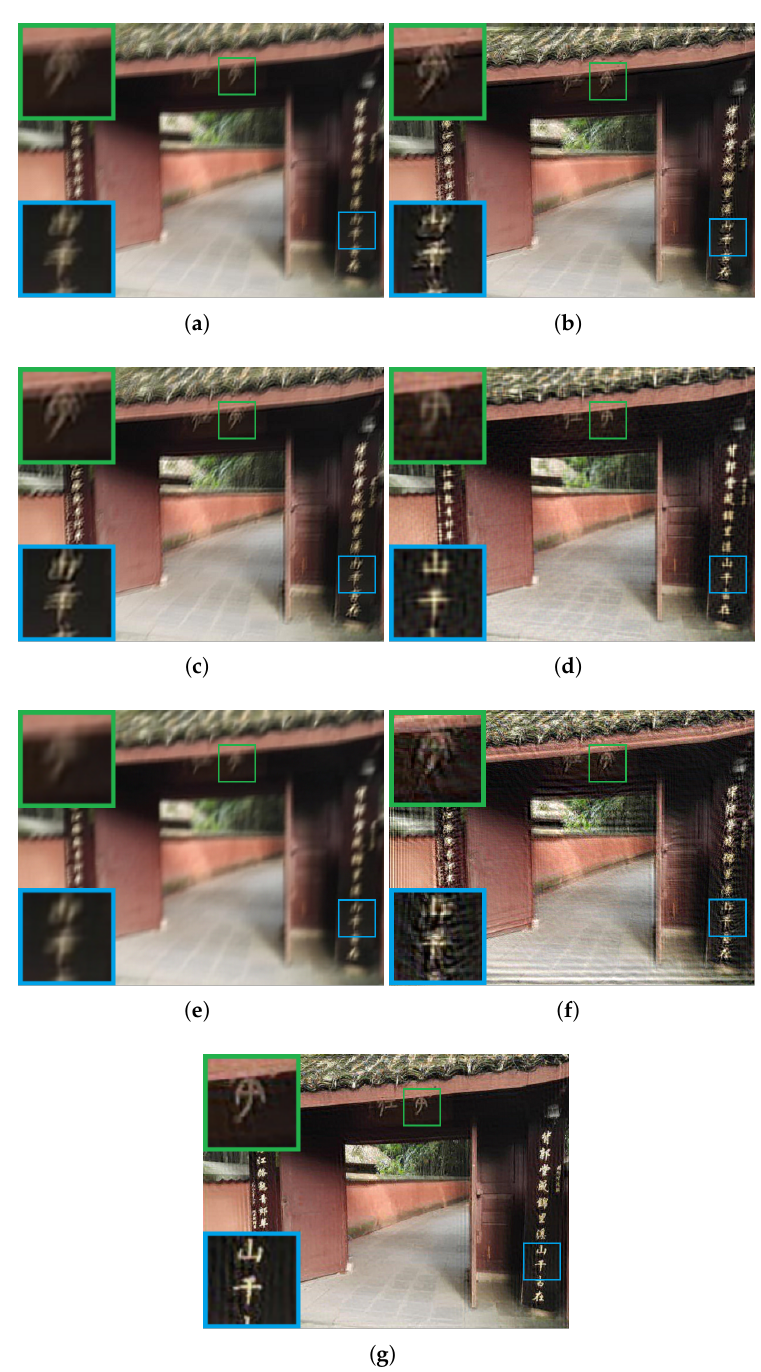
Figure 4. Comparison of different deblurring algorithms using a motion blur and continuous defocus blur image. ( a ) the input blur image; ( b ) the deblurring result of Xu’s method [33] (PSNR = 17.34, SSIM = 0.58); ( c ) the deblurring result of Shen’s method [34] (PSNR = 33.13, SSIM = 0.94); ( d ) the deblurring result of Yang’s method [35] (PSNR = 23.28, SSIM = 0.68); ( e ) the deblurring result of Dong’s method [26] (PSNR = 36.34, SSIM = 0.95); ( f ) the deblurring result of Wiener filter (PSNR = 16.56, SSIM = 0.41); ( g ) the deblurring result of proposed method (PSNR = 38.70, SSIM =